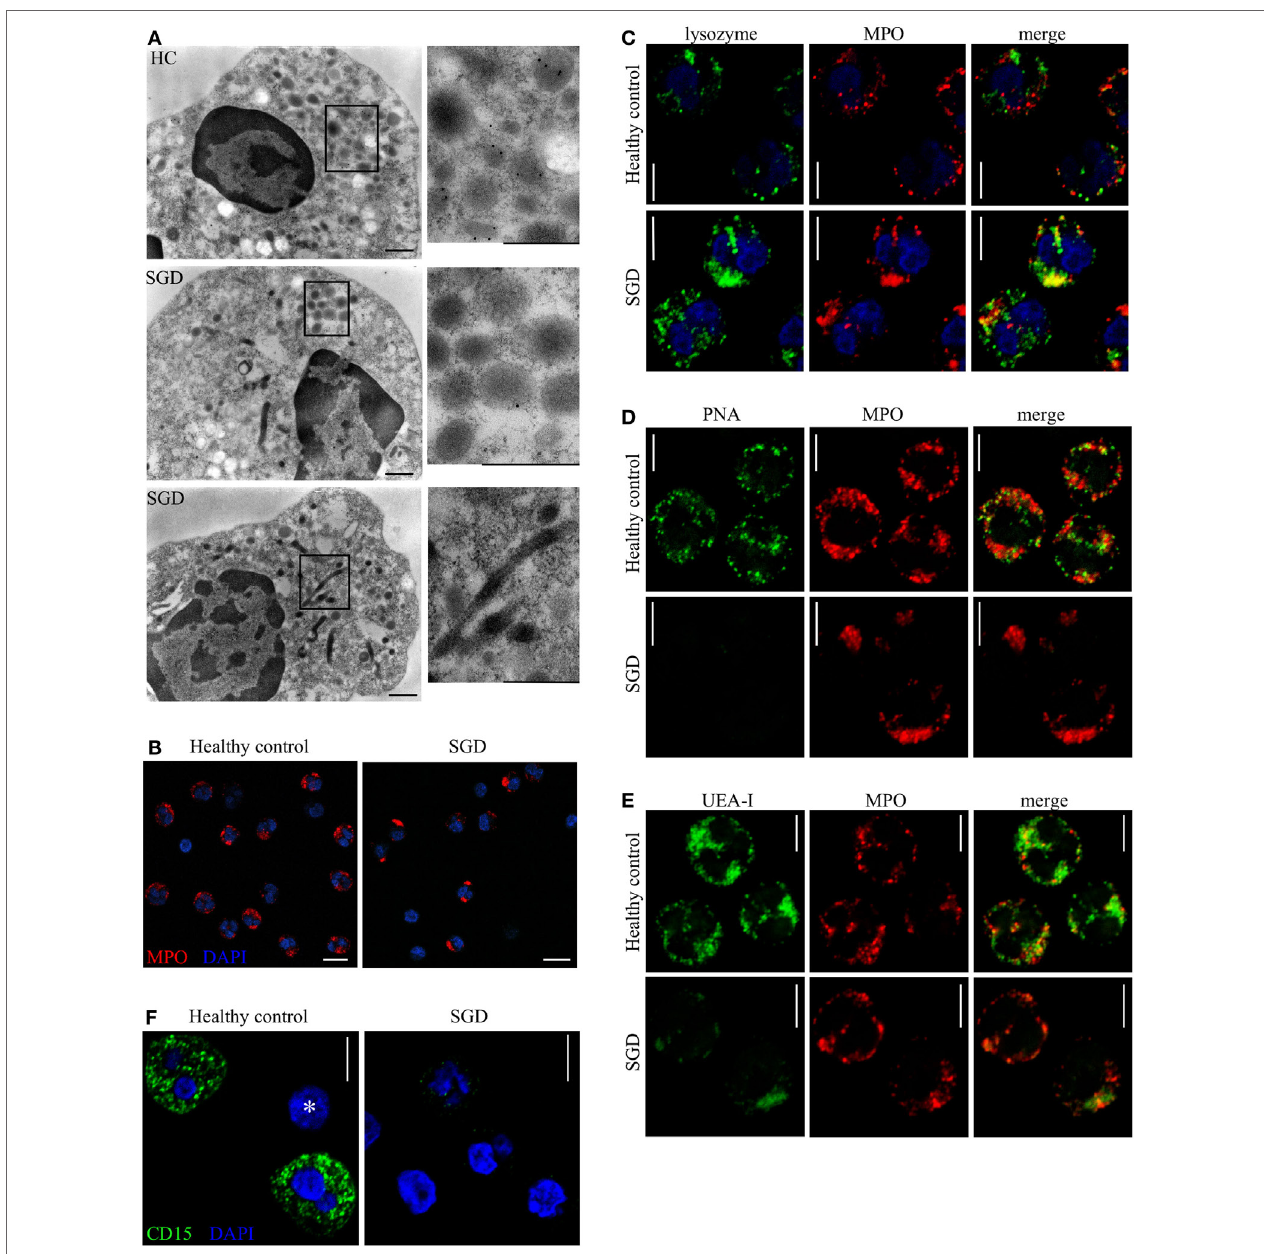
FigUre 3 | Granule distribution, protein content, and glycosylation pattern of neutrophil granules are modified in specific granule deficiency (SGD). (a) Immunoelectron microscopy shows presence of lactoferrin (15 nm gold particles) in secondary granules in healthy controls (HCs, upper panel) and its absence in two SGD patients (two lower panels). Elongated sacs as well as aggregates of granules are observed in SGD but not in HCs (see zoomed in panels). Scale bars: 500 nm. (B) MPO-containing granules (red) are aggregated and polarized in SGD compared with HCs as shown by confocal immunofluorescence. Scale bar: 10 µm. (c) Lysozyme (green) co-localizes with MPO (red) in neutrophils of SGD patients (lower panel) but not of HCs (upper panel). (D,e) Different populations of granules are recognized specifically by the lectins (green) peanut agglutinin (PNA) (D) and UEA-I (e) in HCs (upper panel), displaying, respectively, no or partial co-localization with MPO (red). The granules in SGD neutrophils (lower panel) are not recognized by PNA (D) and react weakly with Ulex europaeus agglutinin I (UEA-I) (e) compared with HCs. (F) The anti-CD15 (green) staining is reduced in neutrophils of SGD patients (right) compared with healthy donor (left). No staining is visible in a lymphocyte in the healthy donor (asterisk). Scale bars (c–F) : 5